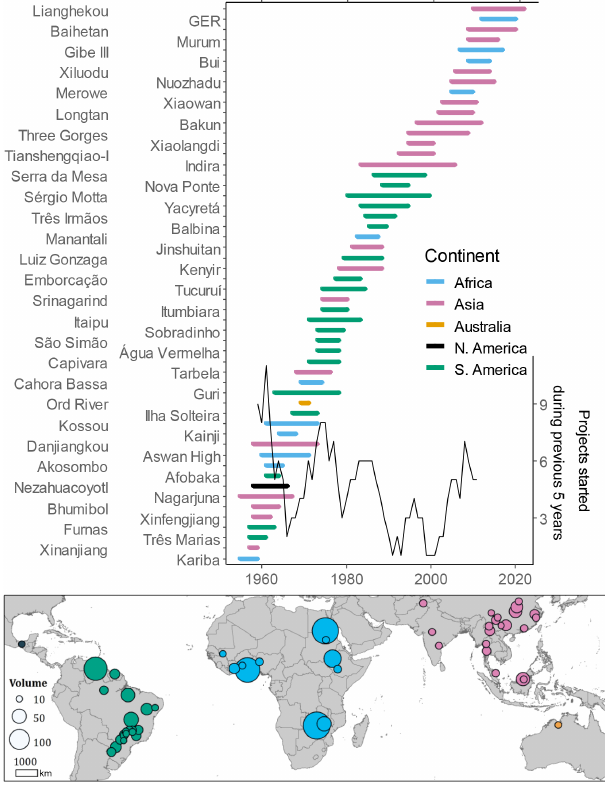
Figure 1. Construction history of the world’s 54 largest reservoirs located below ± 35 ◦ latitude. Project year of completion data are from the International Commission on Large Dams (https://www. icold-cigb.net/, last access: 1 November 2018). Project start data are approximate ( ± 1 year) and based on either gray literature source or for some more recent dams, i.e., visual inspection of Google Earth satellite imagery. Grand Ethiopian Renaissance abbreviated as GER. Volume in map legend is in cubic